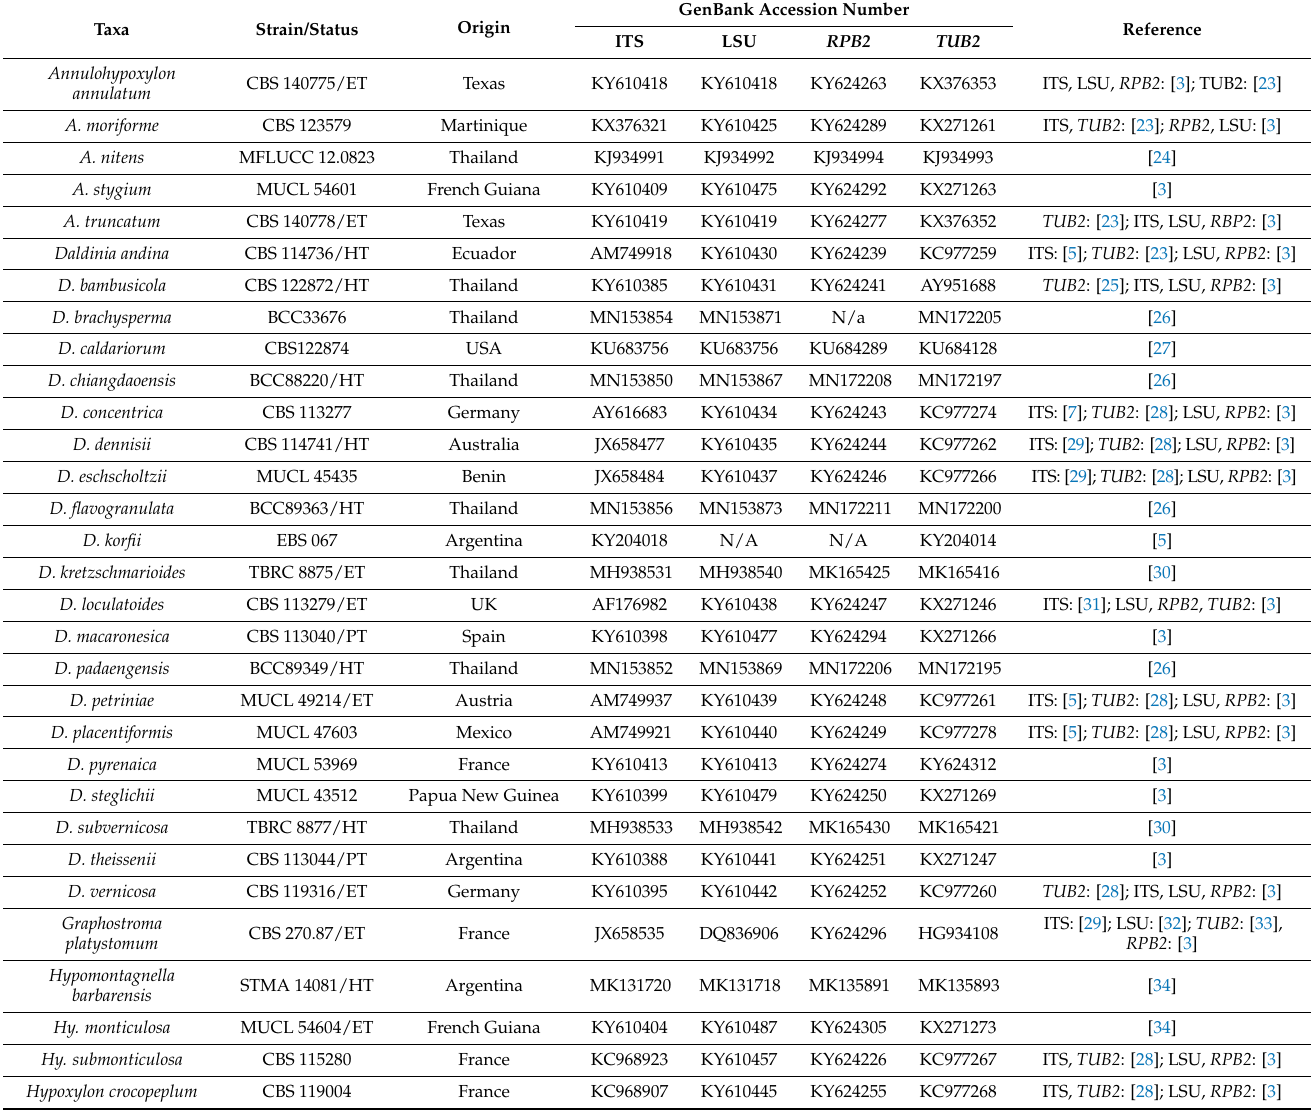
Table 1. List of all taxa used in the current phylogenetic